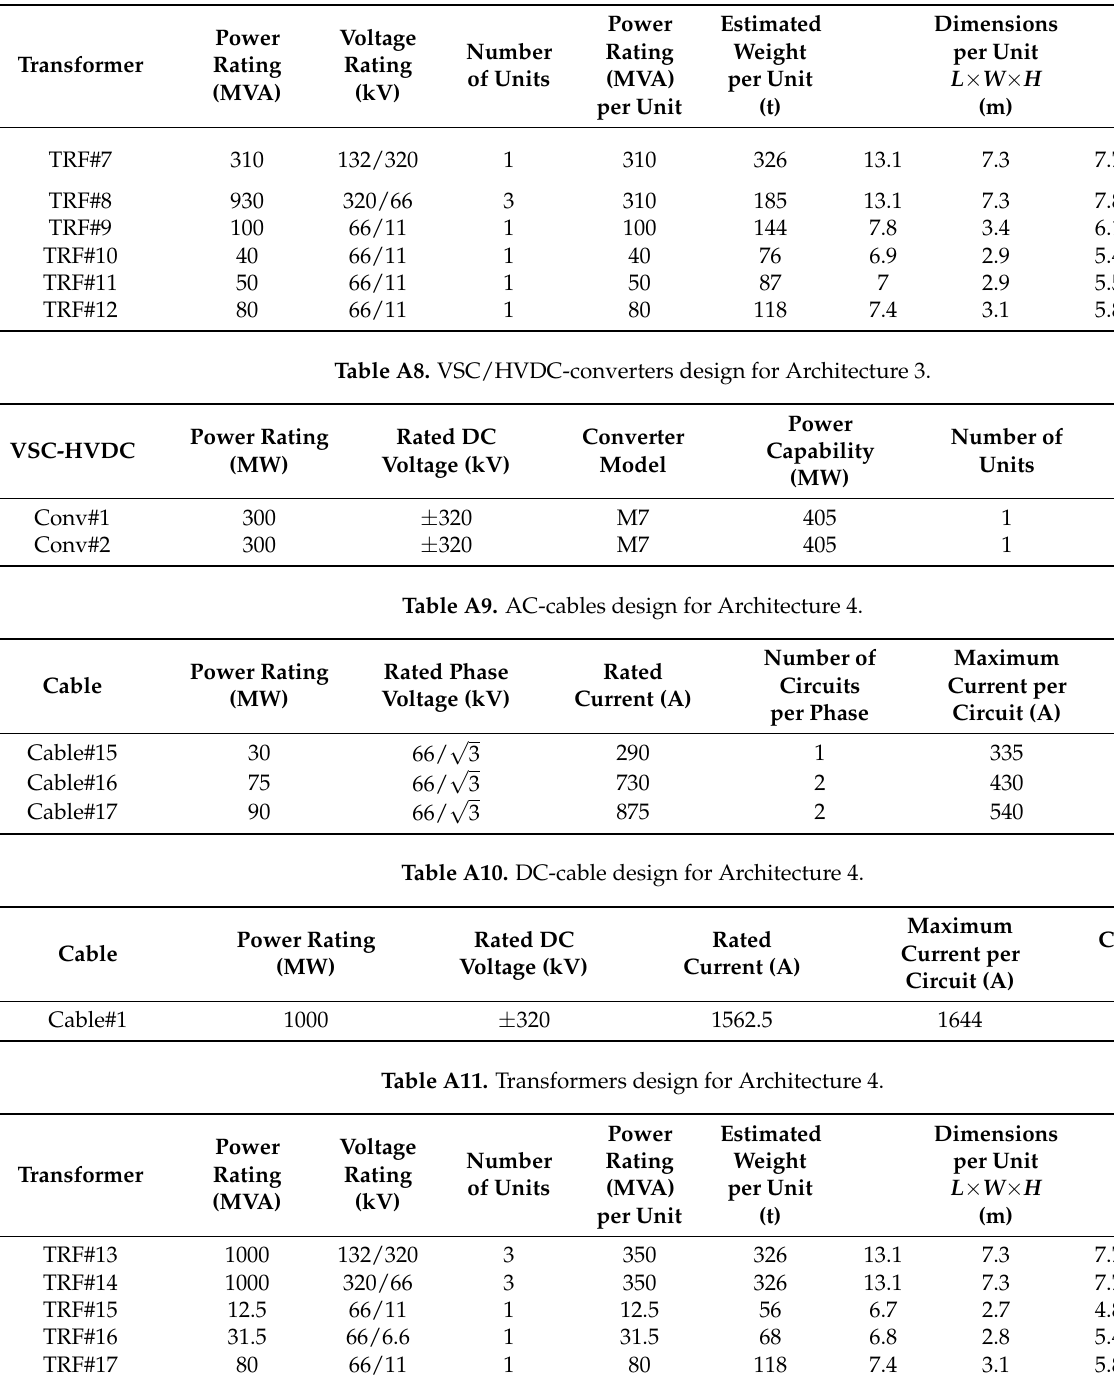
Table A7. Transformers design for Architecture 3.